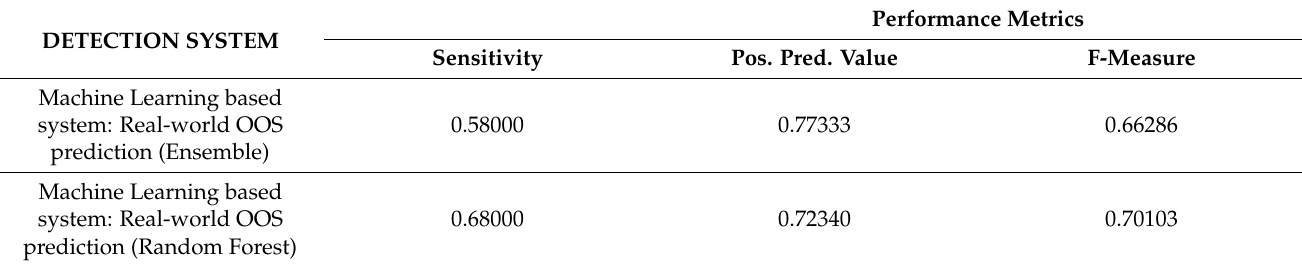
Table 10. Machine Learning Based System Real-world Performance